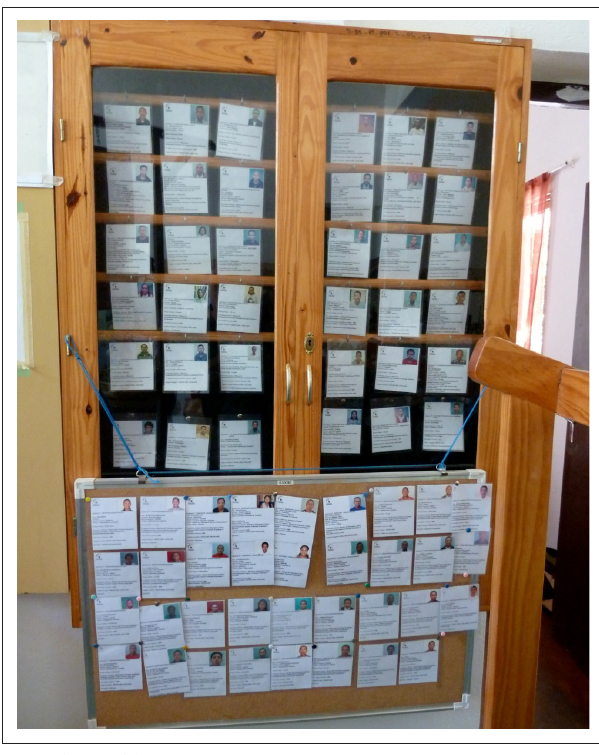
FIGURE 3: Cabinet located at Andasibe National Park with records of approved and registered tour guides working in the park. The majority of guides live in the village of